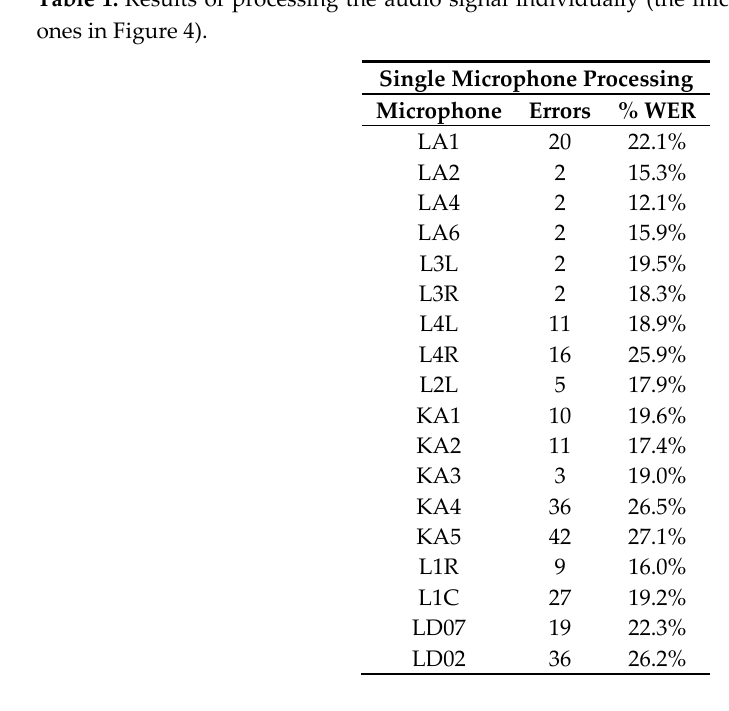
Table 2. Results of the audio analysis based on the proposed approach for different microphone groups.